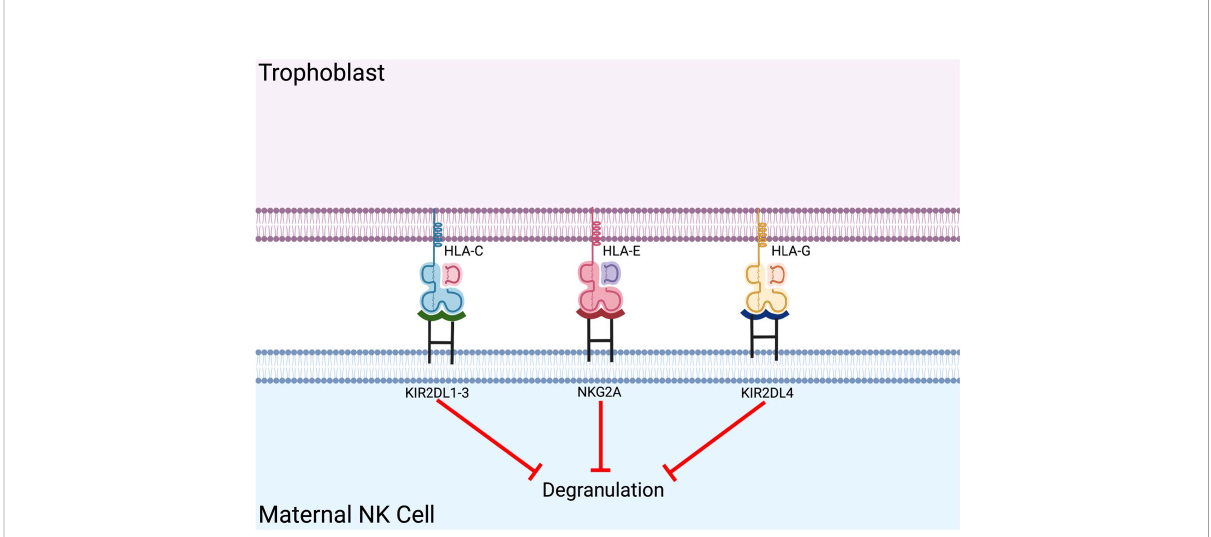
FIGURE 2 Co-expression of fetal HLA-C, HLA-E, and HLA-G in extravillous trophoblasts provides inhibitory signals to maternal NK cells. Maternal NK cell tolerance is established via expression of fetal classical and non-classical HLA class I molecules on the placental extravillous